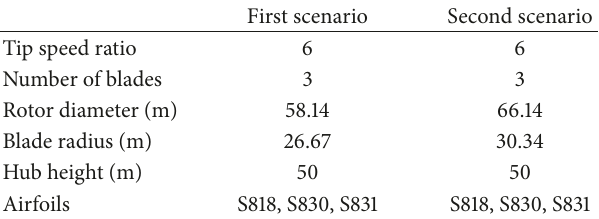
Current model Khalfallah and Koliub Figure 3: Validation of HAWT.